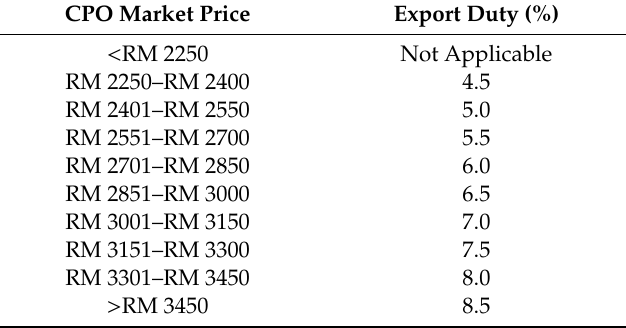
Table 2. Export duty rate for palm oil in Malaysia (source: Malaysian Palm Oil Board (MPOB)).